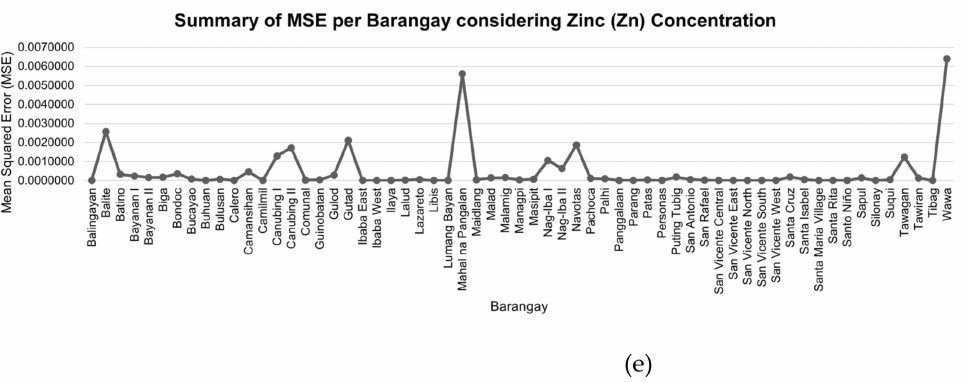
Figure 14. Summary of MSE per Barangay considering ( a ) Ba, ( b ) Cu, ( c ) Fe, ( d ) Mn, and ( e )